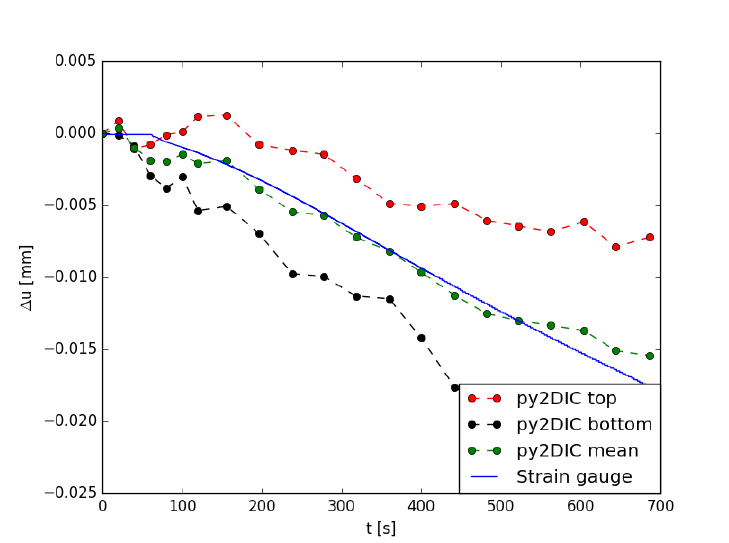
Figure 15. Comparison among py2DIC horizontal displacements and strain gauge measurements